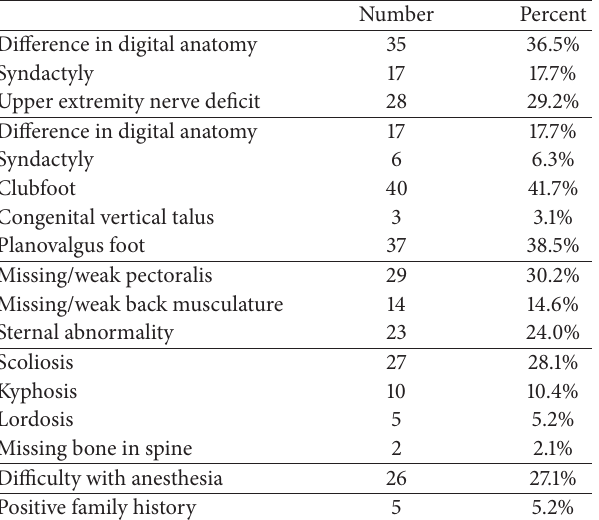
Table 3: Patient survey